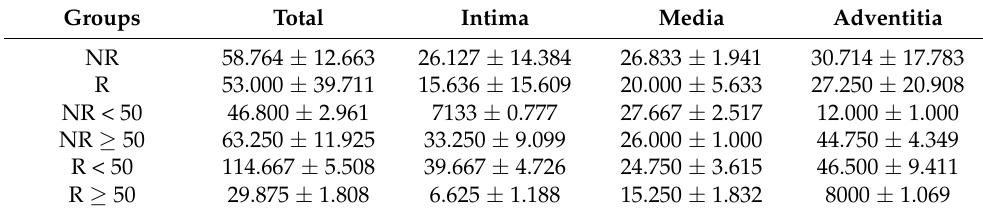
Figure 1. Quantification of the number of elastic fibers in the venous wall and in its three tunics of the different study patients. * p < 0.05, *** p < 0.0001. Table 4. Number of elastic fibers determined by orcein. Mean ±